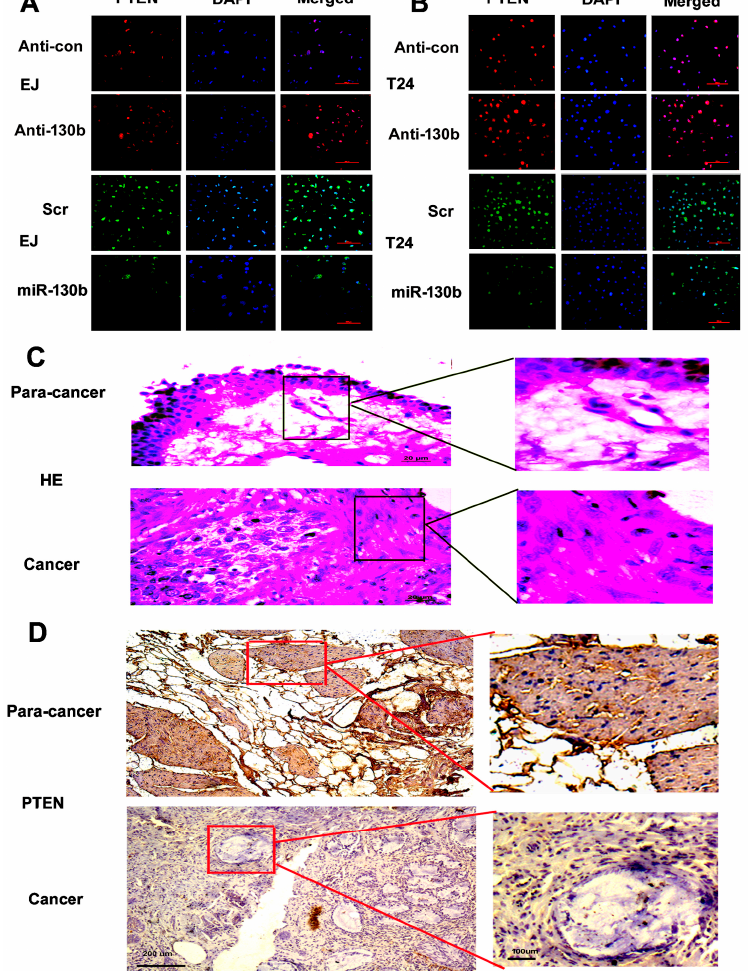
Figure 9. miR-130b-3p regulates the expressions of PTEN in cells and the expressions of PTEN are determined in human tissues. ( A , B ) Immunofluorescence analysis of PTEN in EJ and T24 cells transfected with miR-130b mimics, the scramble control, anti-130b or anti-con, respectively. Scale bar = 100 μ m; ( C ) Representative photographs of hematoxylin-eosin (HE) staining of bladder carcinoma and para-carcinoma tissues. Scale bar = 20 μ m; and ( D ) Representative images of immunohistochemical staining of tissues with antibody of PTEN. Scale bar = 200 μ m ( left ), 100 μ m ( right ).